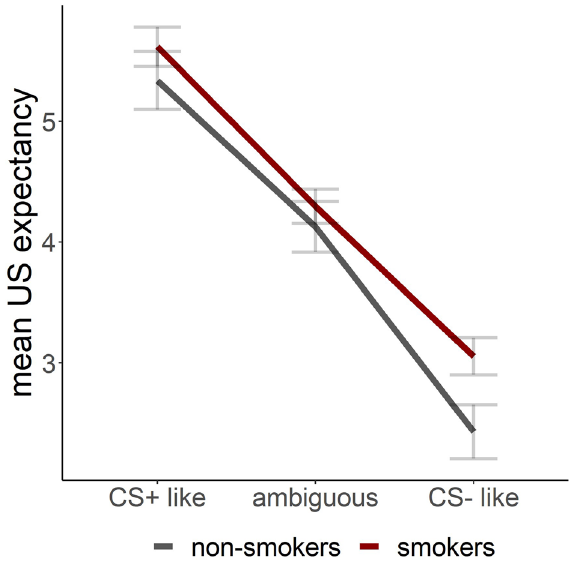
Figure 3. Day 2 mean US expectancy for grouped stimuli. Participants rated their US expectancy trialwise during the generalization test on day2 for CS+, CS− and the eight generalized stimuli in between (GS2–GS9). Rating results from the non-smoking group were used to define the grouping of stimuli. Stimuli that did not differ from CS+ were grouped as CS + like (CS+, GS2, GS3), stimuli that differed between CS+ and CS− were grouped as ambiguous (GS4–GS7) and stimuli that did not differ from CS− were grouped as CS-like (CS8, GS9, CS−). There is a trend towards a group difference between smokers and non-smokers when comparing CS− like stimuli during the generalization test on day 2. No differences were found between smokers and non-smokers for CS+ like and ambiguous